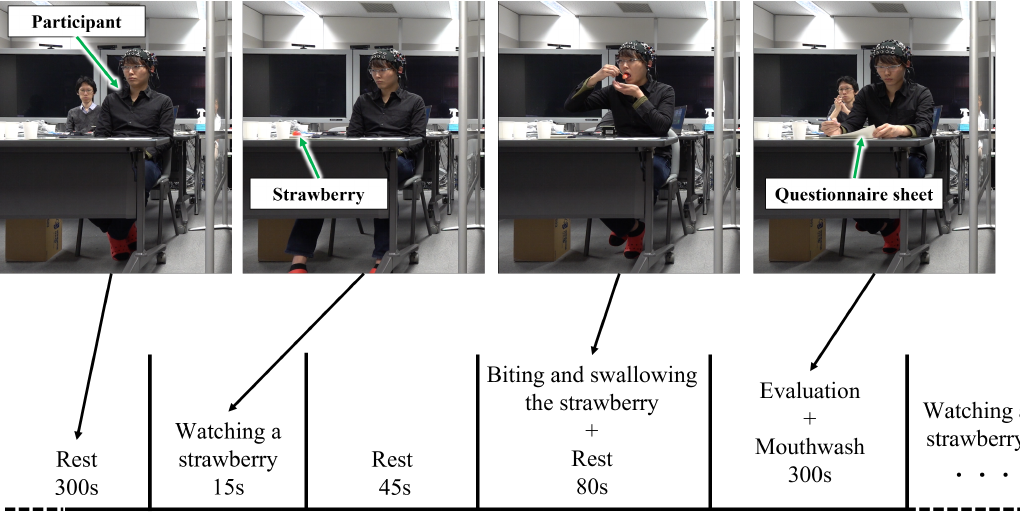
Figure 2. Schematic diagram of the rest and task sequences in the experiment. The signal of the temporal brain area was recorded by fNIRS during the biting and swallowing of the strawberry. After recording, evaluations of the VAS and some questionnaires were conducted. These tasks were repeated for four strawberries per participant. Note that a five-minute gap between tasks was the same condition as in the literature